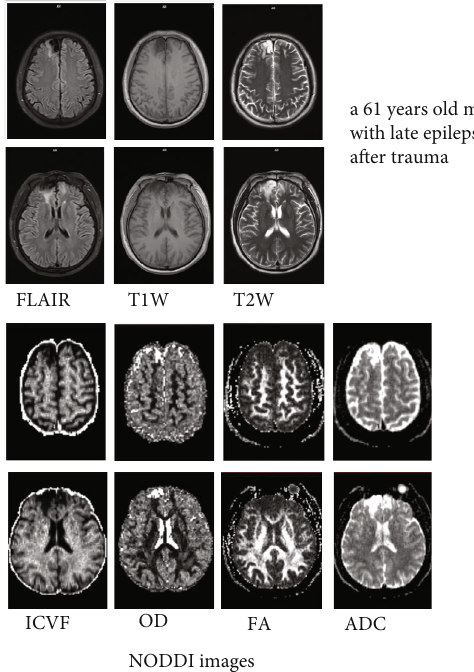
Figure 2: A 61-year-old man had late epilepsy that occurred six months after trauma. He had an encephalomalacia with FLAIR hyperintense lesions in both frontal lobes (FLAIR, T1W and T2W images, and NODDI ICVF, OD, FA, and ADC images).